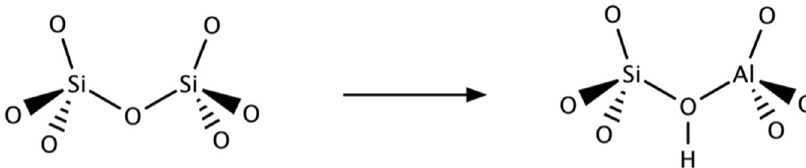
Fig. 1 Schematic reaction of brønsted acid site formation. BAS is obtained by replacing a Si 4 + atom in the zeolite frame with a trivalent